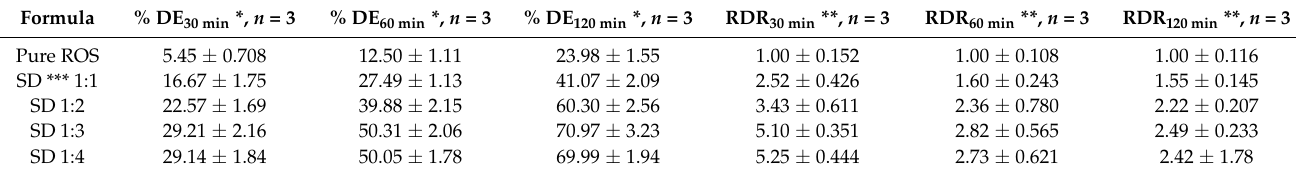
Table 4. % DE and RDR at different times.